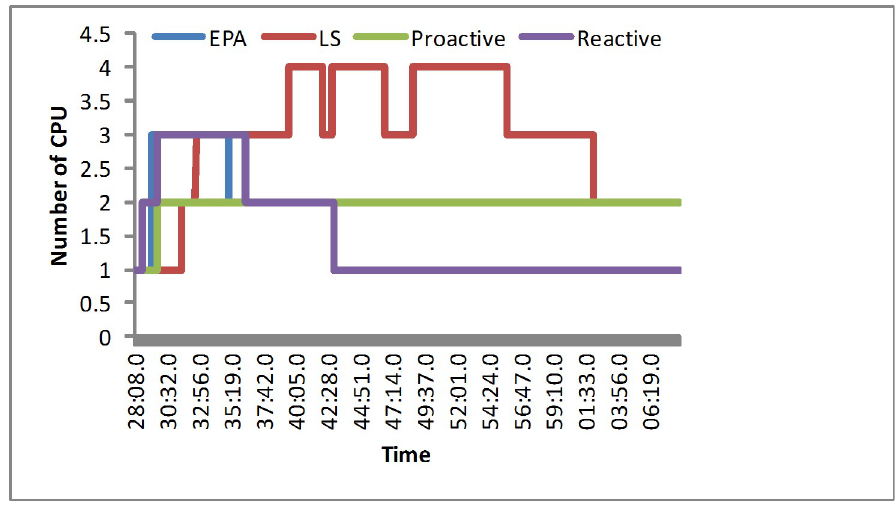
Fig 6. The number of CPUs in the EPA